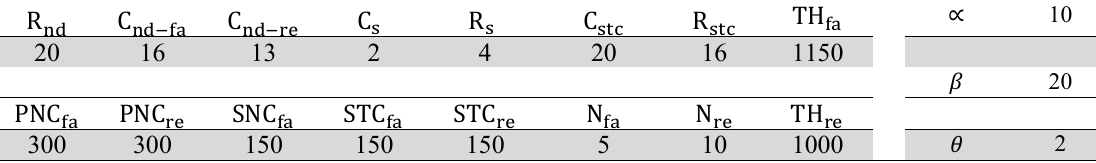
The information of the